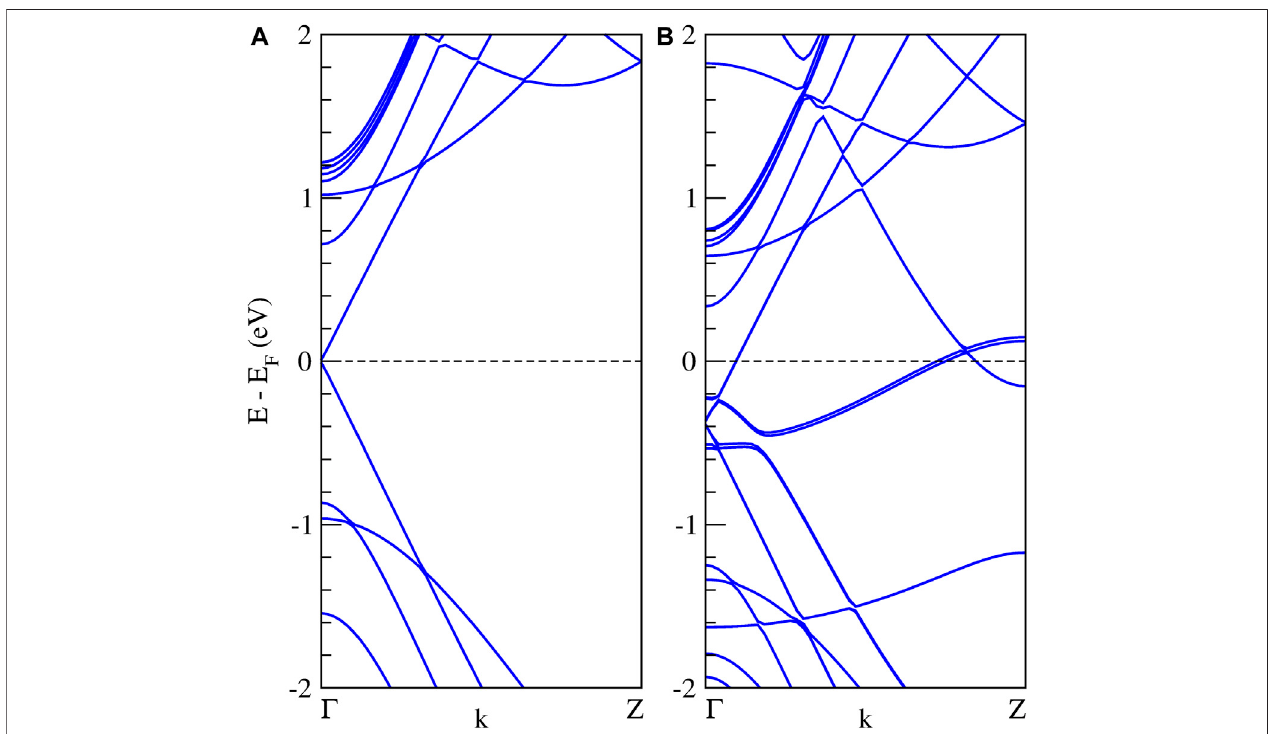
FIGURE 8 | Band structure calculations of the in fi nite Li 6 Si 5 -NW inside the zigzag carbon nanotubes, (A) the isolated (15,0) CNT, and (B) the Li 6 Si 5 -NW@CNT system. The dashed line indicates the Fermi energy.